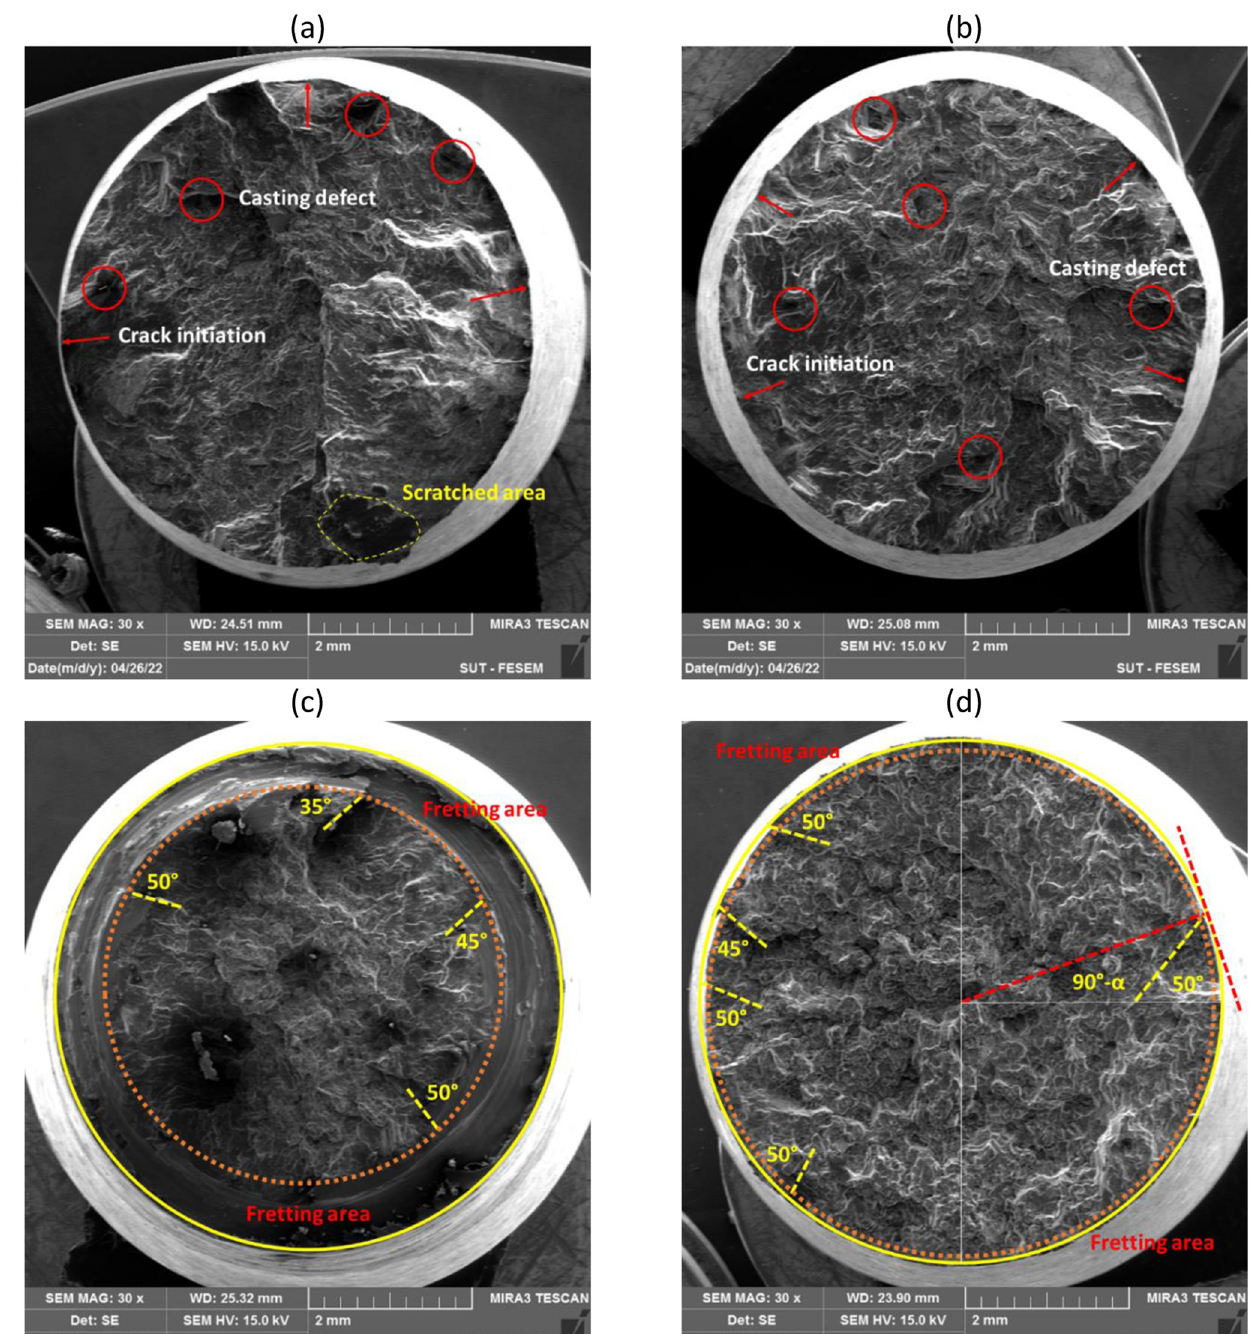
Fig 6. The fracture surface under pure fatigue at the stress level of (a) 80 MPa and (b) 120 MPa and under fretting fatigue at the stress levels of (c) 80 MPa and (d) 120 MPa. https://doi.org/10.1371/journal.pone.0281263.g006 gave way to the latter with a rise in the stress intensity component, which was the driving force behind crack growth. The driving force should be strong enough to produce a premature frac- ture or to cause β -phase debonding [13, 39]. The majority of the facets in the specimen fracture surface were intergranular, as shown by Hashemi et al. [39]. The rate of crack propagation is